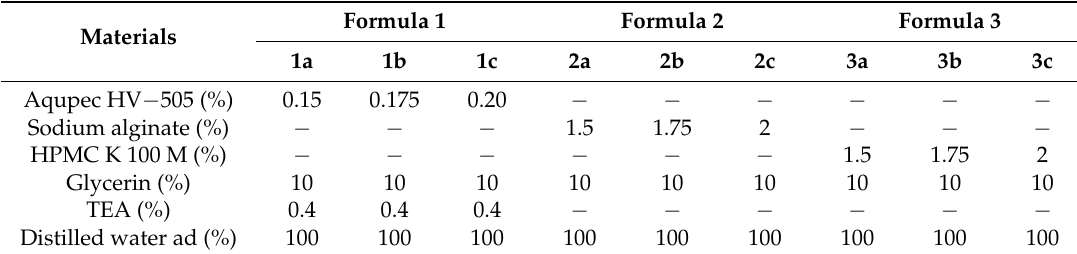
Table 1. Preparation of hydrogel